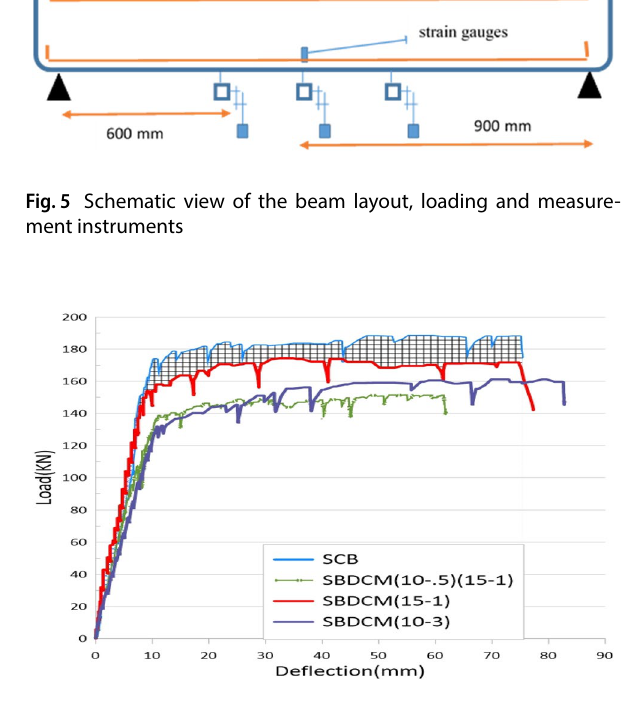
Fig. 6 Load–displacement diagrams of specimens having degrada- tion in the middle